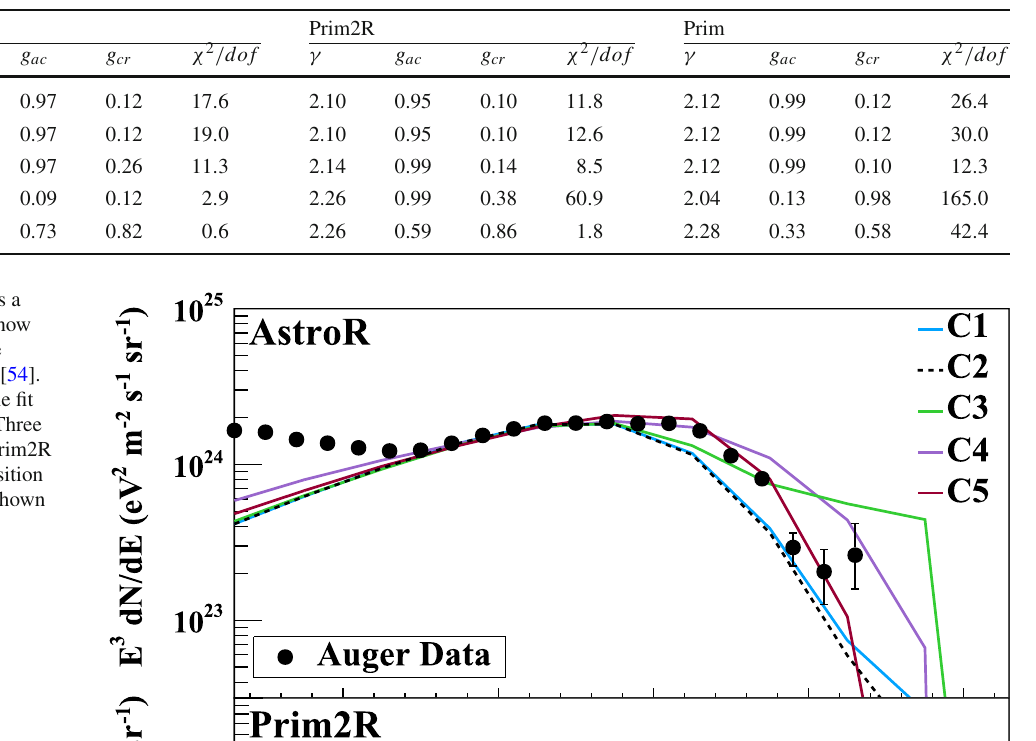
Table 2 Results of the fit of the energy spectrum Composition